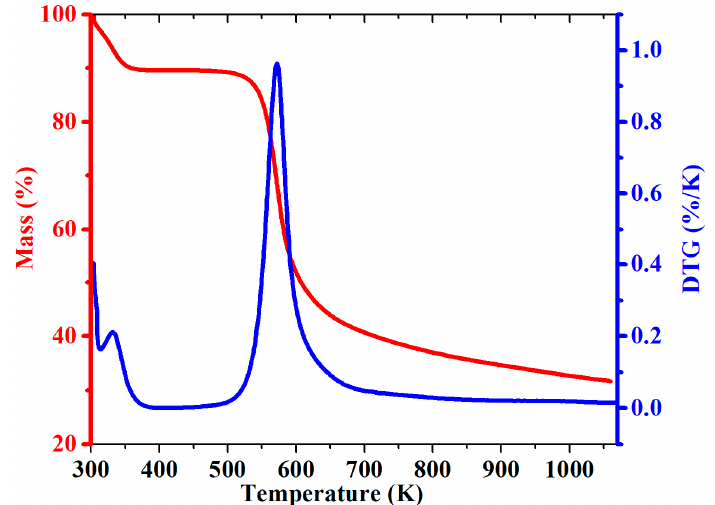
Figure 3. Thermogravcimetric (red line) and derivative curves (blue line) for pristine CH biopolymer. Thermogravcimetric and derivative curves for pristine CH biopolymer.